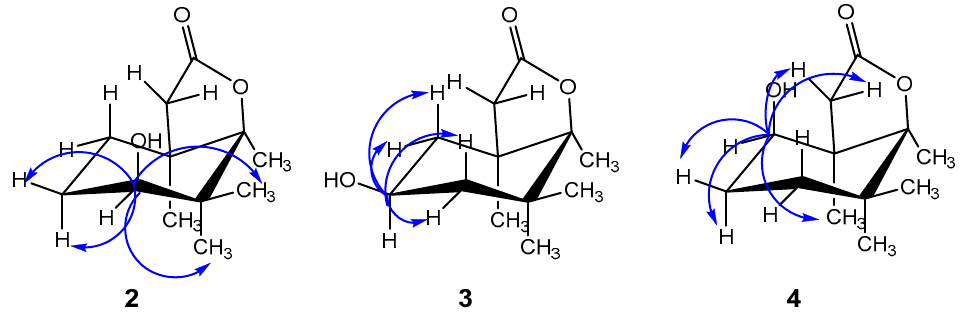
Figure 1. Determination of the hydroxyl function location using relevant H-C correlations from the HMBC spectra.